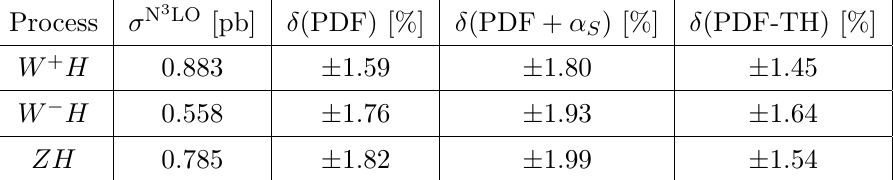
Table 4 . Total cross section for associated Higgs production at N 3 LO in QCD, at a 13 TeV pp collider for a fixed central scale choice µ used. The symmetrical PDF, PDF+ α